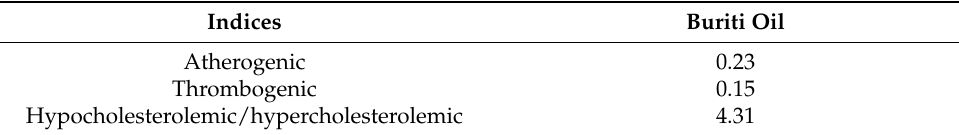
Table 2. Indices of nutritional quality of buriti oil.